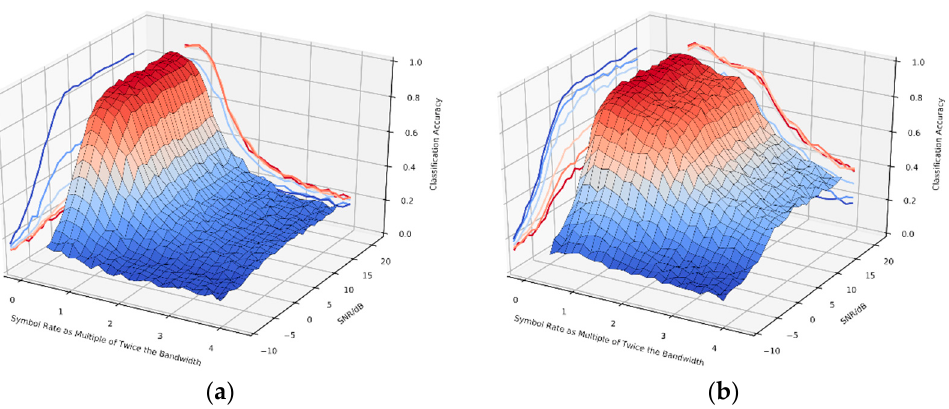
Figure 5. Overall classification accuracy of baseline classifier for various training scenarios vs. sample rate offsets and SNR. ( a ) SRO1; ( b ) SRO2.